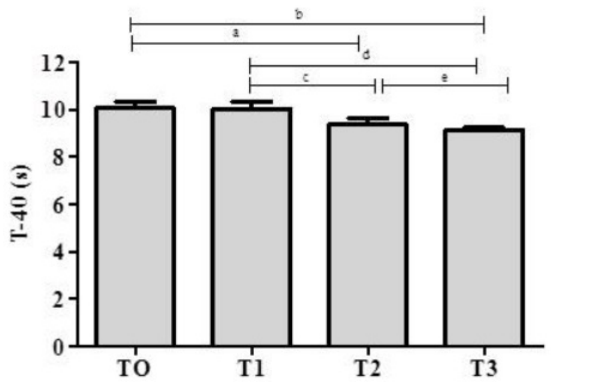
Figure 2. Cyclic-acyclic velocity displacement during the periodiza-